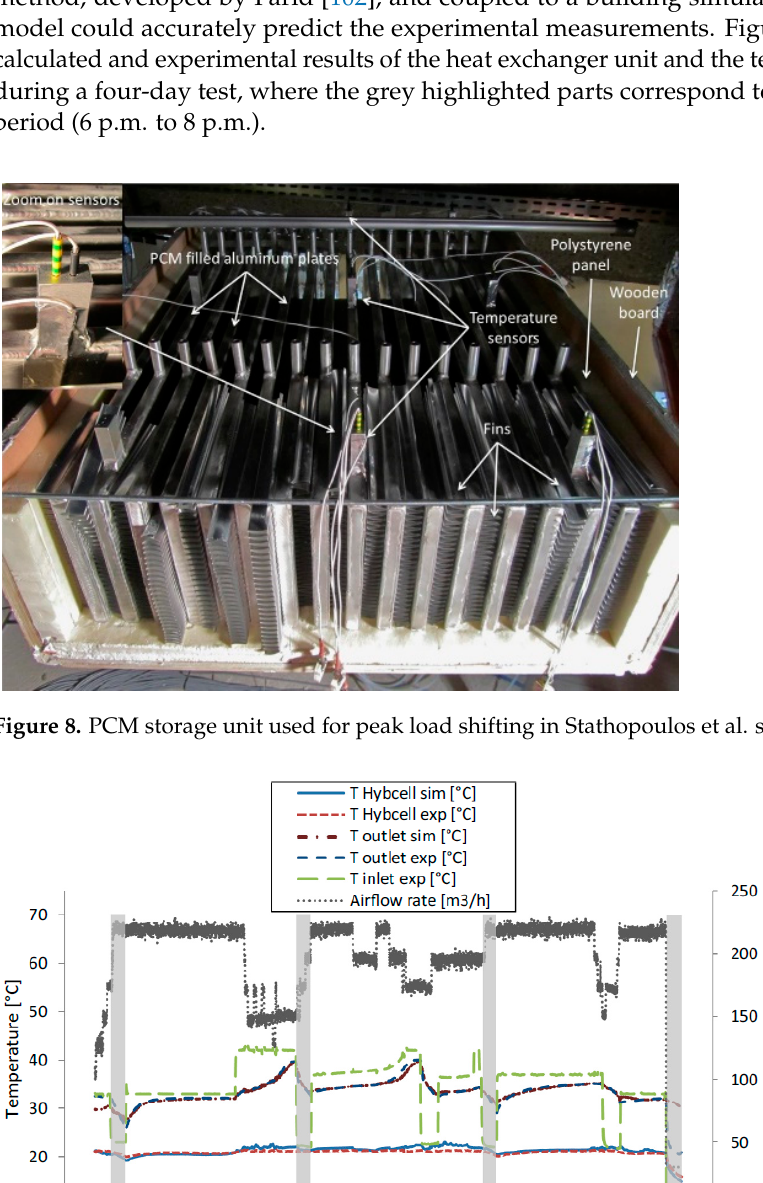
Figure 9. Numerical and experimental results for the PCM storage unit for peak load shifting over four days [101].